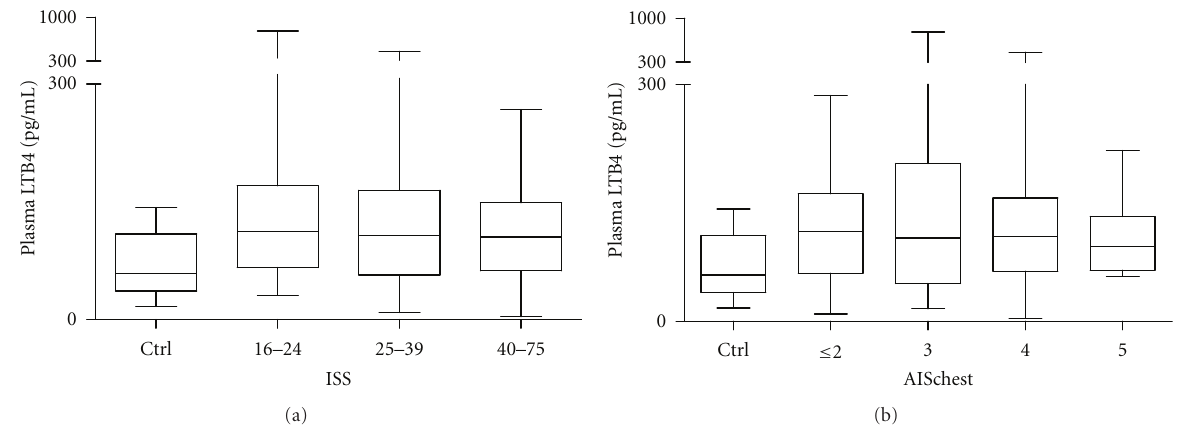
Figure 2: Summary of median (interquartile range) LTB4 (pg/mL) in ED samples in di ff erent groups of patients based on the overall injury severity (a) and the severity of chest injury (b). (a) ISS: 16–24, n = 17, ISS: 25–39, n = 54, ISS: ≥ 40, n = 29 and ctrl group, n = 10. (b)